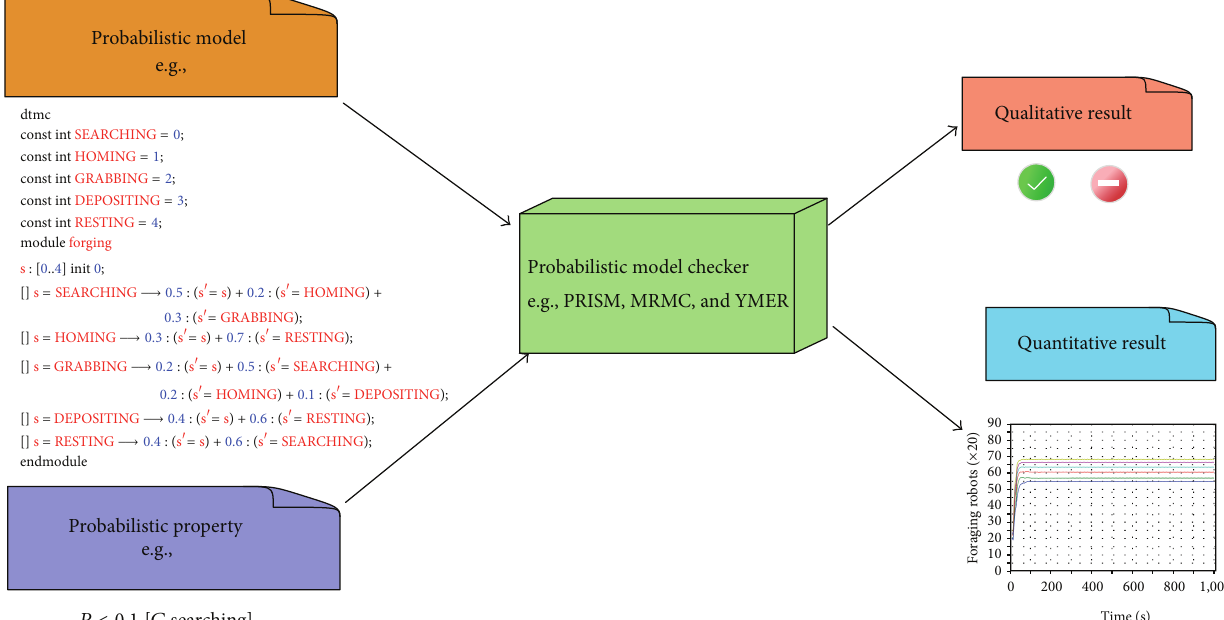
Figure 1: Standard approach for probabilistic model